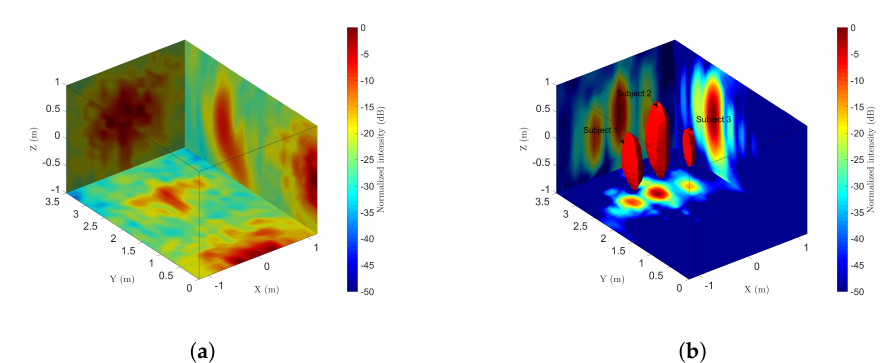
Figure 7. Line-of-sight detection results of multiple subjects. ( a ) Projection of the initial 3-D image. ( b ) Projection and CFAR detection of the fourth-order